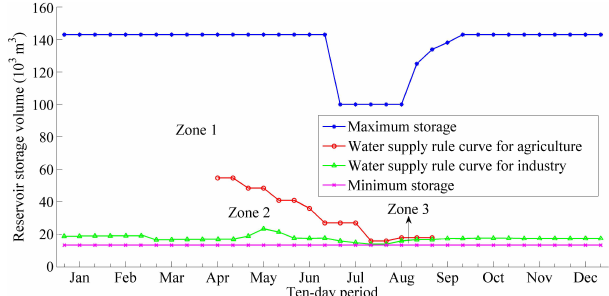
Figure 1. Reservoir operational rule